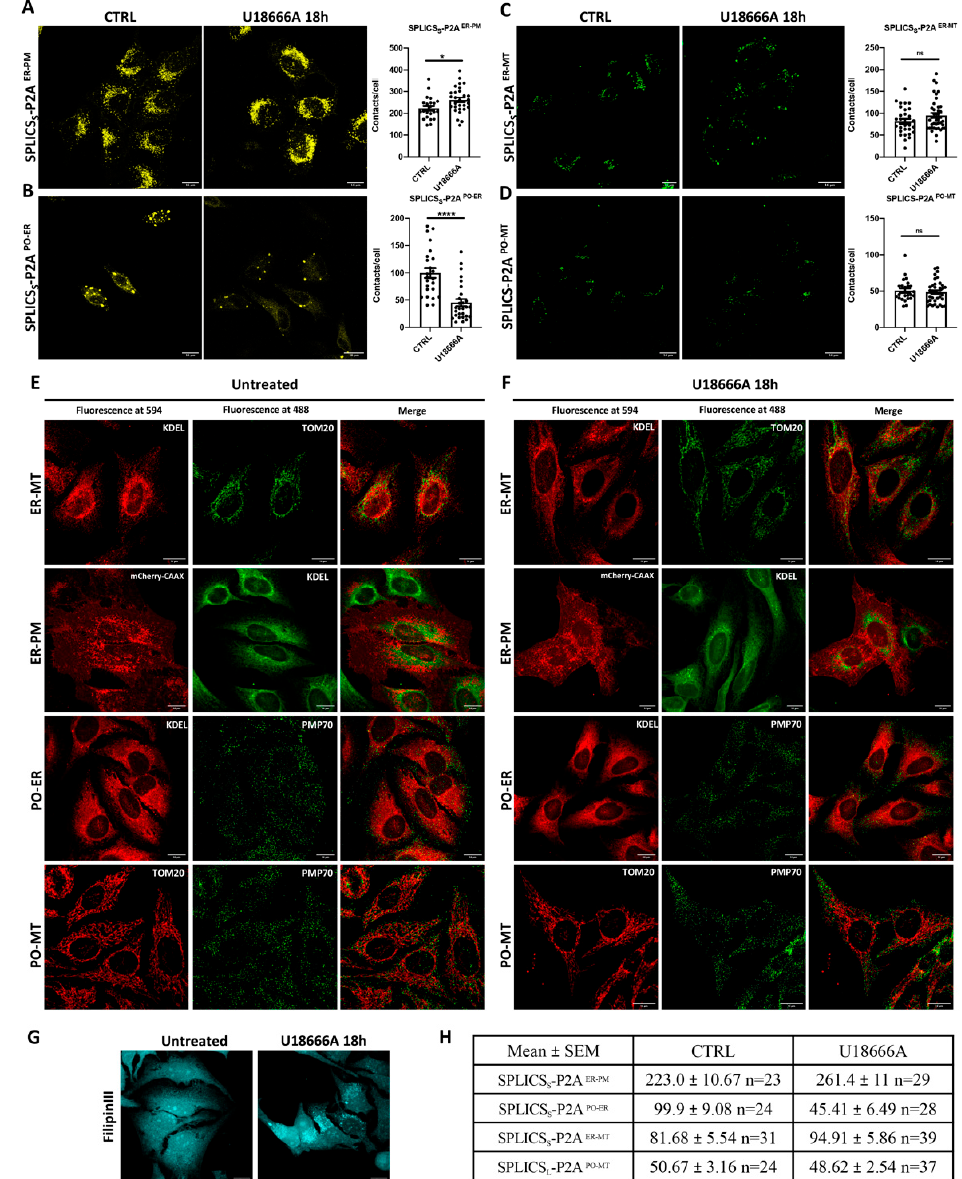
Figure 5. Effect of U18666A treatment in HeLa polyclonal stable cell lines expressing SPLICS SER-PM , SPLICS SPO-ER , SPLICS SER-MT , and SPLICS LPO-MT . ( A – D ) Representative Z-projection images of CTRL and U18666A-treated (2 µ g/mL) HeLa expressing SPLICS probes. Cells were treated with U18666A for 18 h after 24-h stimulation with 10 ng/mL doxycycline for SPLICS SER-PM , SPLICS SER-MT , and SPLICS L PO-MT , and with 500 ng/mL doxycycline for SPLICS S PO-ER . Quantification of the indicated SPLICS contact sites/cell was performed from the 3D rendering of a complete Z-stack in CTRL and U18666A treatment conditions. ns: not significant. ( E , F ) Immunofluorescence analysis in cells untreated ( E ) and treated ( F ) with U18666A showing the morphology of ER and mitochondria, ER and PM, peroxisomes and ER, and peroxisomes and mitochondria. Endogenous markers used are shown. ( G ) Filipin II staining in HeLa cells showing cholesterol accumulation upon U18666A treatment. ( H ) Mean ± SEM values of the number of ER-PM, PO-ER, ER-MT, and PO-MT contacts in mock- and U18666A-treated cells. Data are shown as mean ± SEM dots ( n = 3 independent experiments) and analyzed by t -test (* p < 0.05, **** p < 0.0001). To eliminate the possibility that the increase in ER-PM and the decrease in PO-ER contacts numbers observed in Figure 5A upon U18666A treatment were due to changes